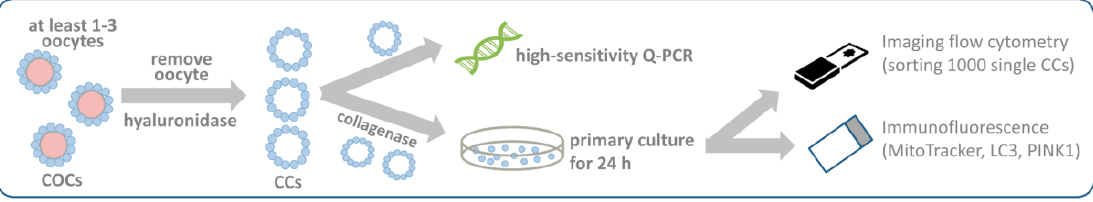
Figure 2. Flow chart of experimental design.